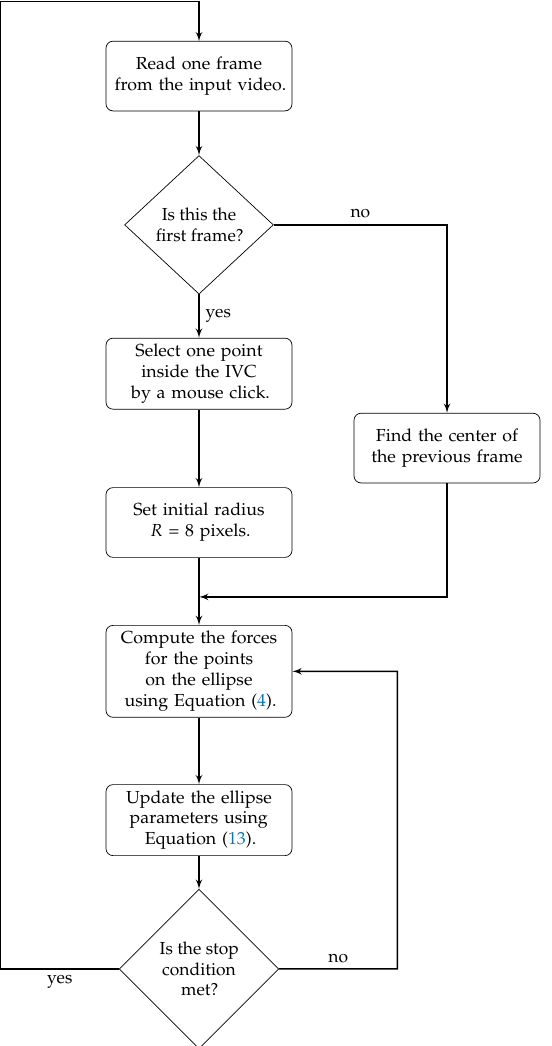
Figure 1. Flowchart for the proposed active ellipse algorithm for estimation and tracking of the IVC AP-diameter from ultrasound